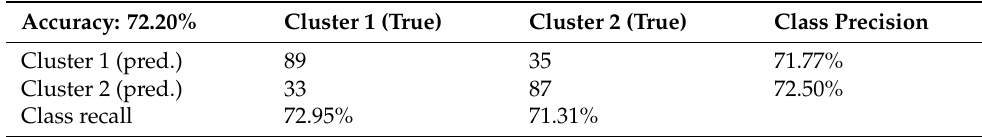
Table 3. Confusion matrix for prediction performance of training data.